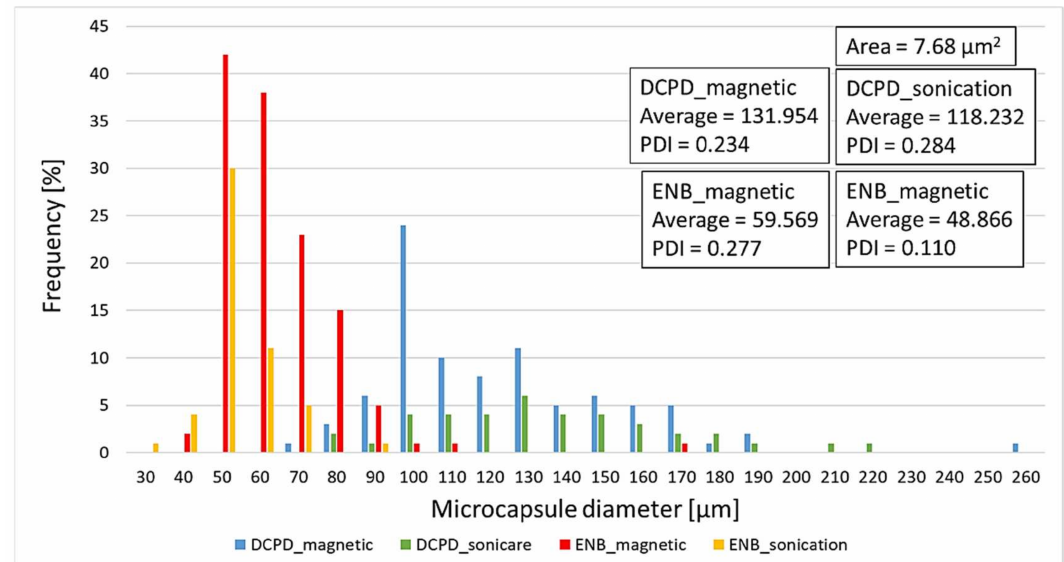
Figure 6. Statistical calculation of microcapsule